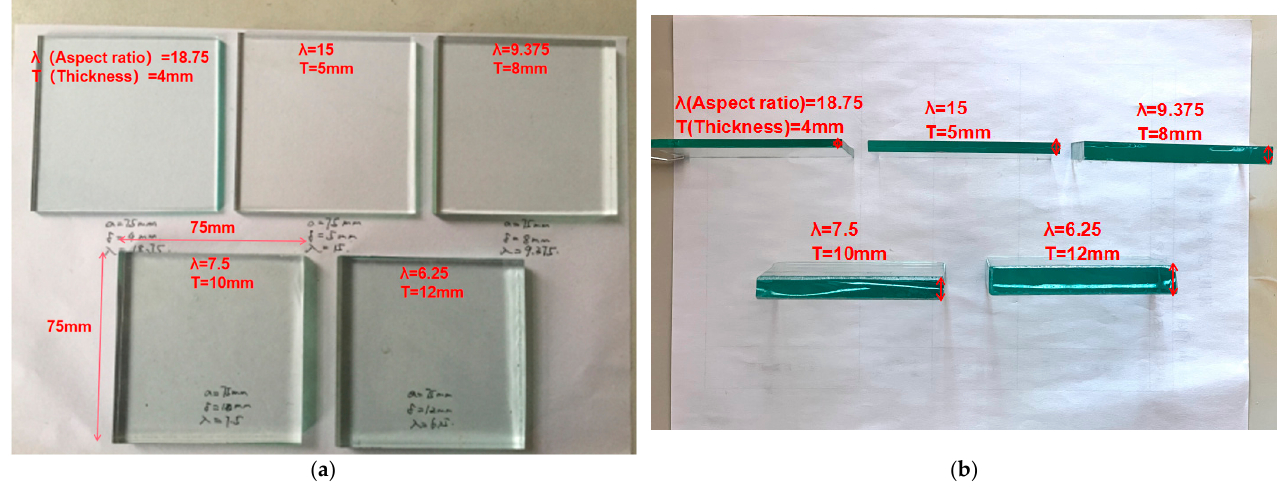
Figure 2. Glass sheet test pieces with di ff erent aspect ratios:( a ) Top view;( b ) Side view.